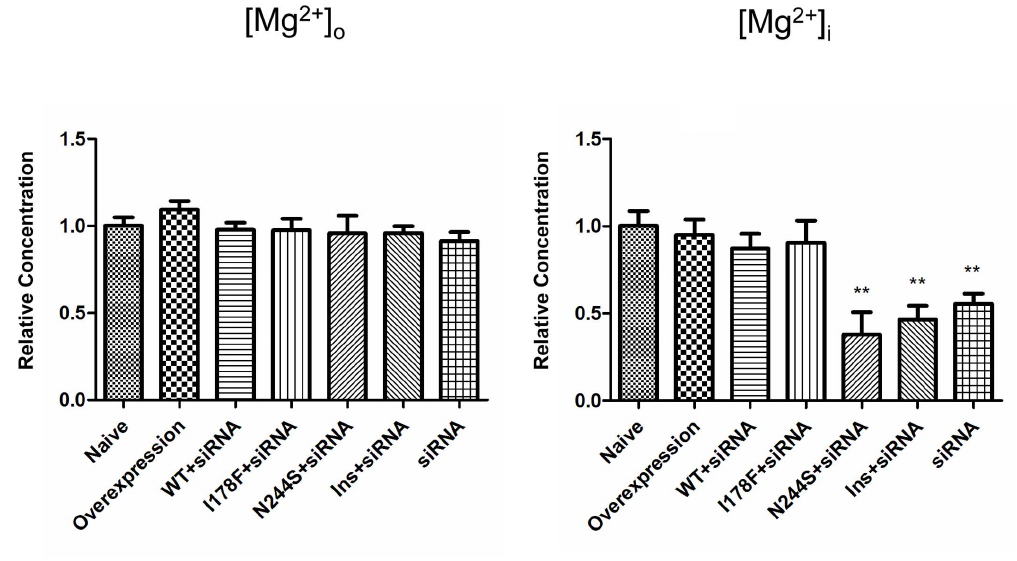
Figure 3. The concentration of extra/intracellular Mg 2 + measured by ICP-OES. There was no significant change of extracellular Mg 2 + concentration among the groups compared to naı¨ve cells; the mutant N244S and Ins dramatically decreased the concentration of intracellular Mg 2 + , though the mutant I178F and the overexpression group were not different from the naı¨ve group. Naı¨ve: the cultured neurons without transfection; Overexpression: neurons transfected with NIPA2 (WT); Ins: N334_E335insD. siRNA: neurons transfected with NIPA2 -siRNA; the group (WT + siRNA): neurons transfected with NIPA2 WT and NIPA2 -siRNA; the mutant + siRNA group (I178F + siRANA, N244S + siRNA, Ins + siRNA): neurons transfected with the mutant and NIPA2 -siRNA. Relative concentration was calculated as: Mg 2 + concentration of the transfected group/Mg 2 + concentration of naı¨ve group. n=4 experiments.